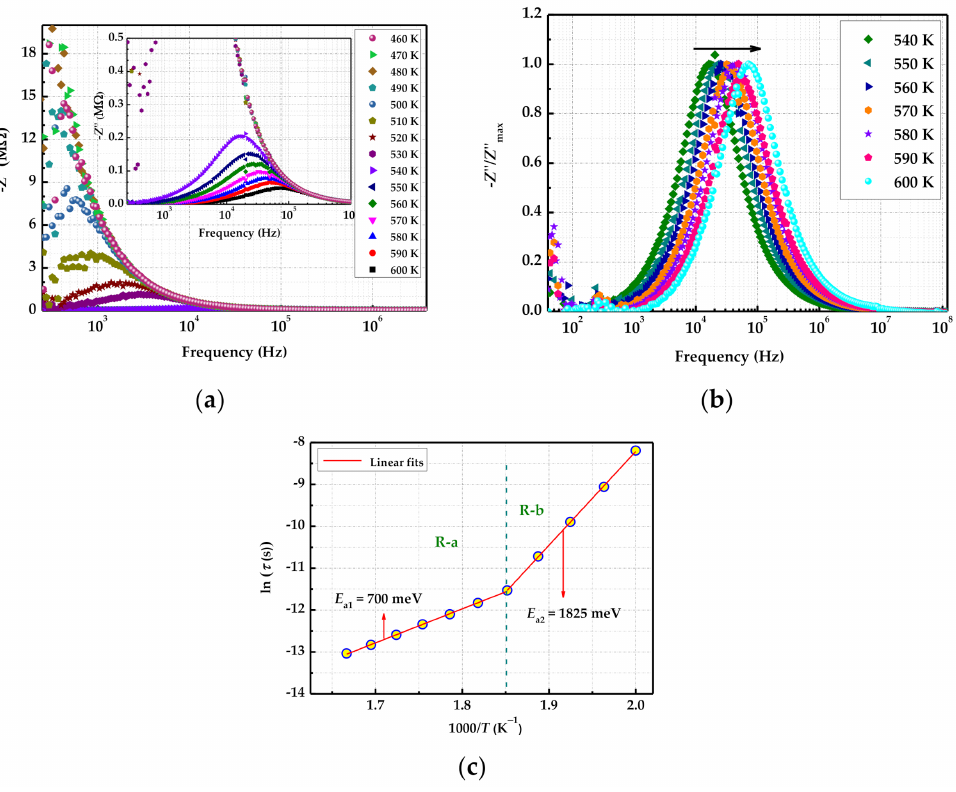
Figure 5. Frequency dependence of the imaginary part of the impedance ( Z ”) of the In 2 S 3 :Ag film: ( a ) in the 460–600 K temperature range; ( b ) normalized to the maximum of the imaginary part of the impedance and for the high temperature range 540–600 K. ( c ) Variation of the relaxation time versus the inverse of the